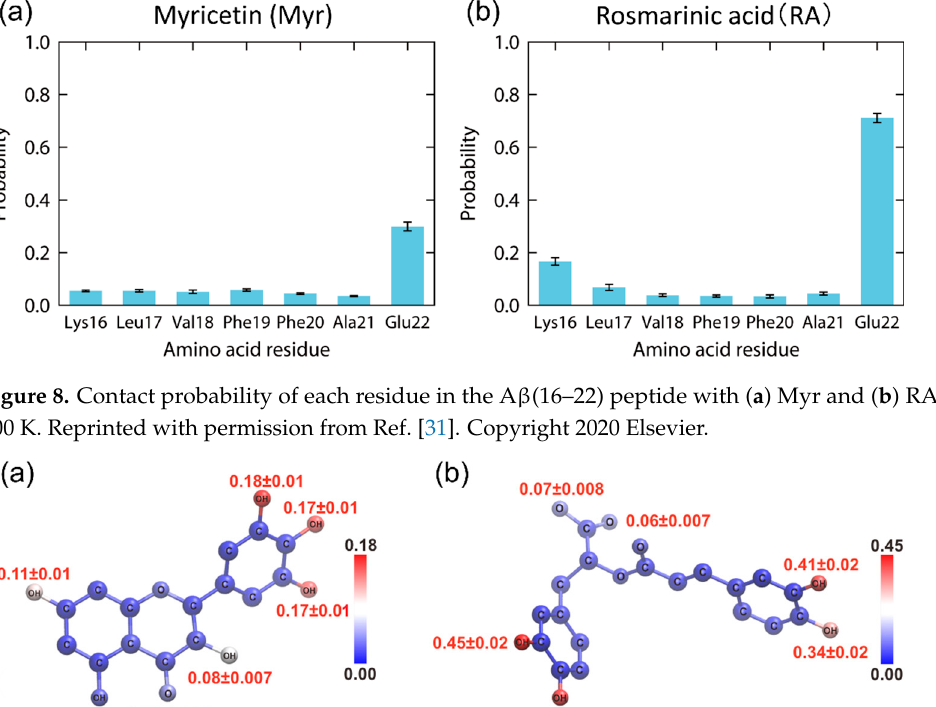
Figure 8. Contact probability of each residue in the A β (16–22) peptide with ( a ) Myr and ( b ) RA at 300 K. Reprinted with permission from Ref. [31]. Copyright 2020 Elsevier.